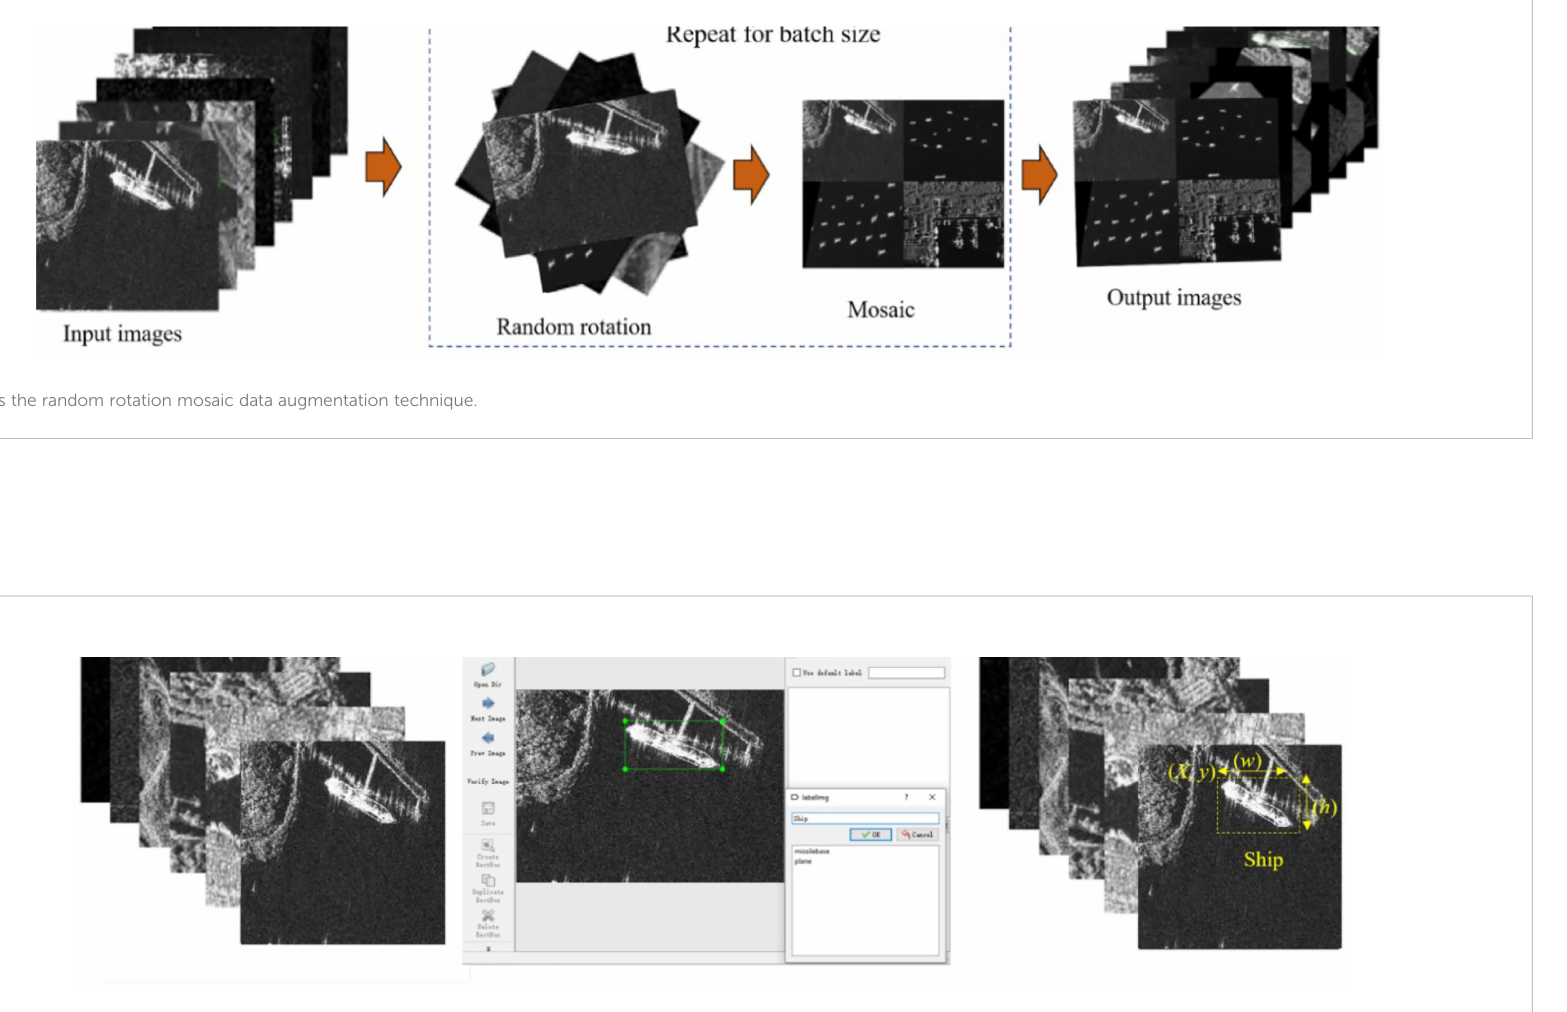
FIGURE 2 SAR images annotation procedures. The parameters of actual ships were obtained using DL algorithms for image annotation, where (x, y) represented for the coordinates of the top left corner of the rectangular box, w for width, and h for